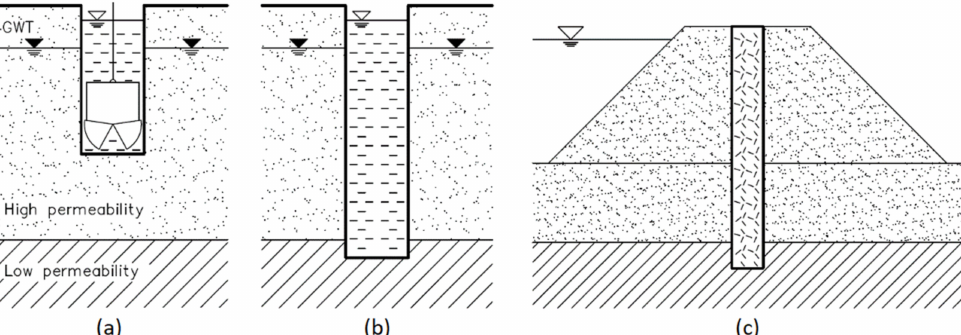
Figure 1. Single-phase execution schematics of a cut-off wall utilizing a hardening slurry: ( a ) deepening of a narrow linear excavation with walls supported by the slurry (added as work progresses); ( b ) excavation at a desired depth, awaiting the bonding of slurry binder; ( c ) sample operating conditions of a hardened slurry in a cut-off wall of an embankment. GWT—groundwater